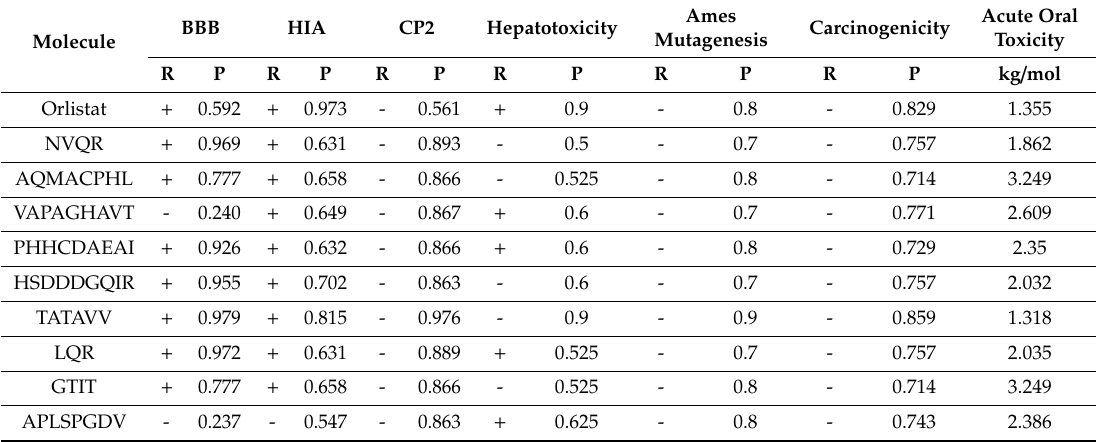
Table 2. Adsorption, Distribution, Metabolism, Excretion, and Toxicity (ADMET) prediction on orlistat and cocoa